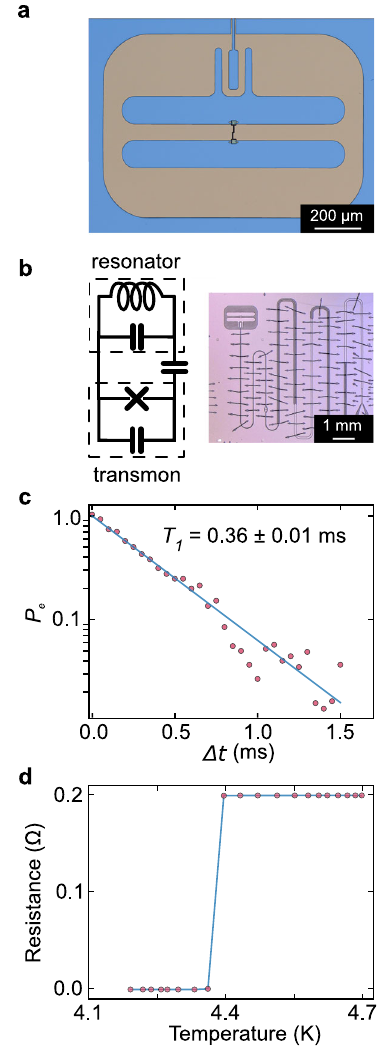
Fig. 1 Tantalum-based transmon superconducting qubit. a False-colored optical microscope image of a transmon qubit. The transmon consists of a Josephson junction shunted by two large capacitor islands made of tantalum (blue) on sapphire (gray). b Device layout image and corresponding circuit diagram of the transmon qubit coupled to the resonator via a coupling capacitor. c T 1 measurement of Device 18, showing the excited state population P e as a function of delay time Δ t . Line represents a single exponential fi t with a characteristic T 1 time of 0.36 ± showing T c = 4.38 ± 0.02 K, consistent with the critical temperature of α